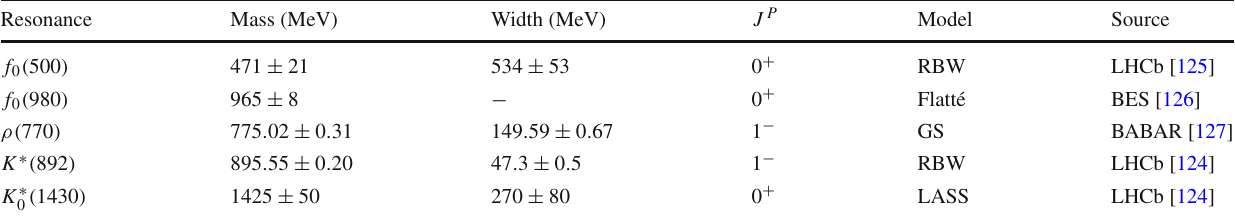
Table 3 Parameters used to describe intermediate states in our framework. GS and RBW refer to the Gounaris-Sakurai and relativistic Breit-Wigner line shapes, respectively Resonance Mass (MeV) Width (MeV) J P Model Source